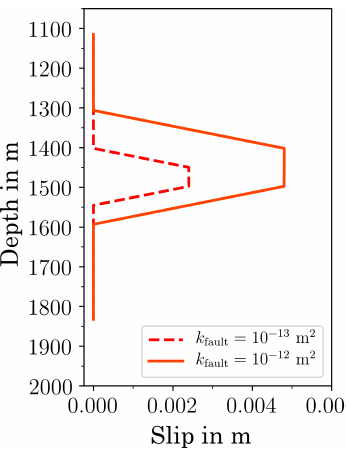
Figure 8. The plot shows the resulting slip after fault reactivation for two different permeabilities. The larger slip occurs in the case with higher